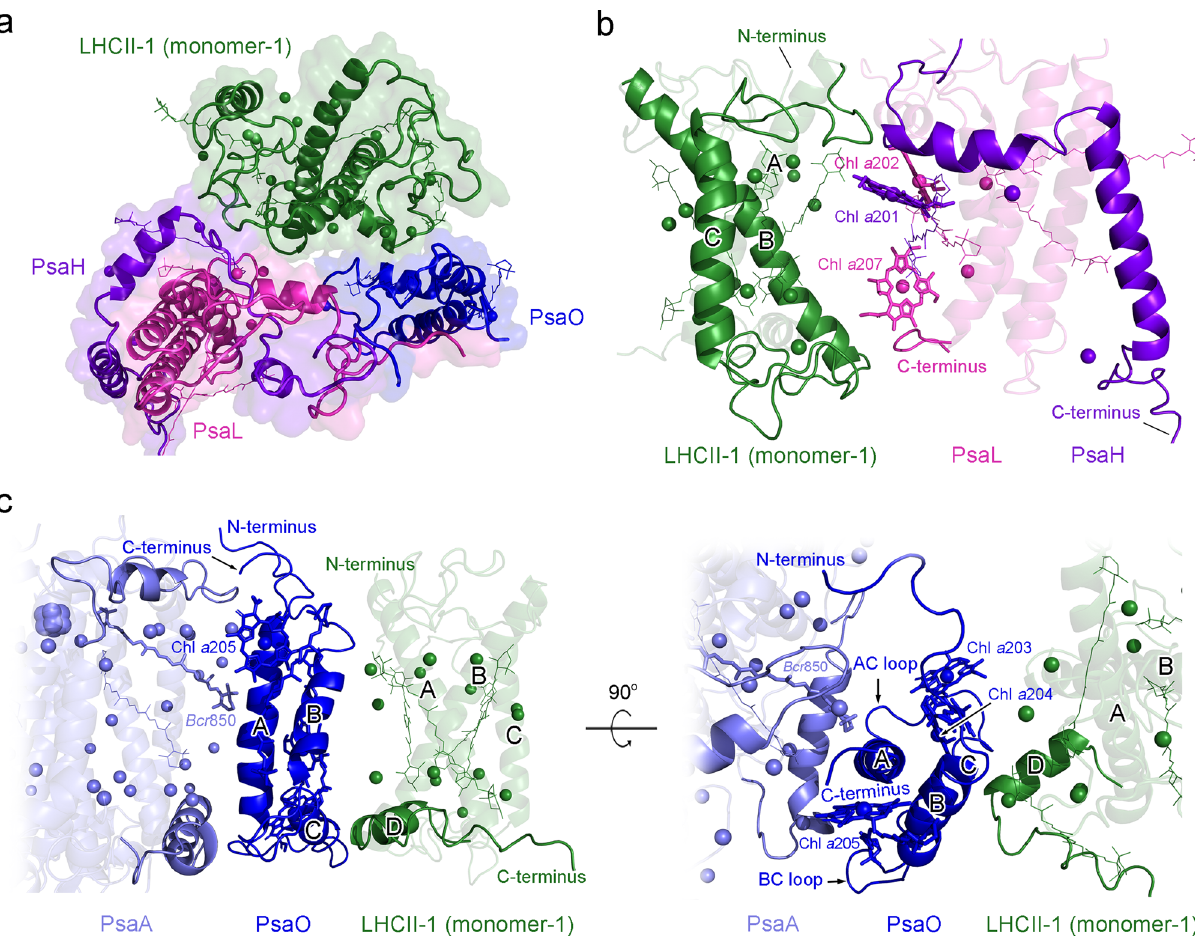
Fig. 6 Interactions between the N-terminal tail of LHCII-1 (monomer-1) with the PSI core subunits in the PSI-LHCI-LHCII supercomplex of C. reinhardtii . a Surface and cartoon representations of the local structure including LHCII-1 (monomer-1), PsaH, PsaL, and PsaO, viewed from the stromal side. b Interactions between LHCII-1 (monomer-1) and PsaL as well as PsaH. c Interactions between LHCII-1 (monomer-1) and PsaA mediated by